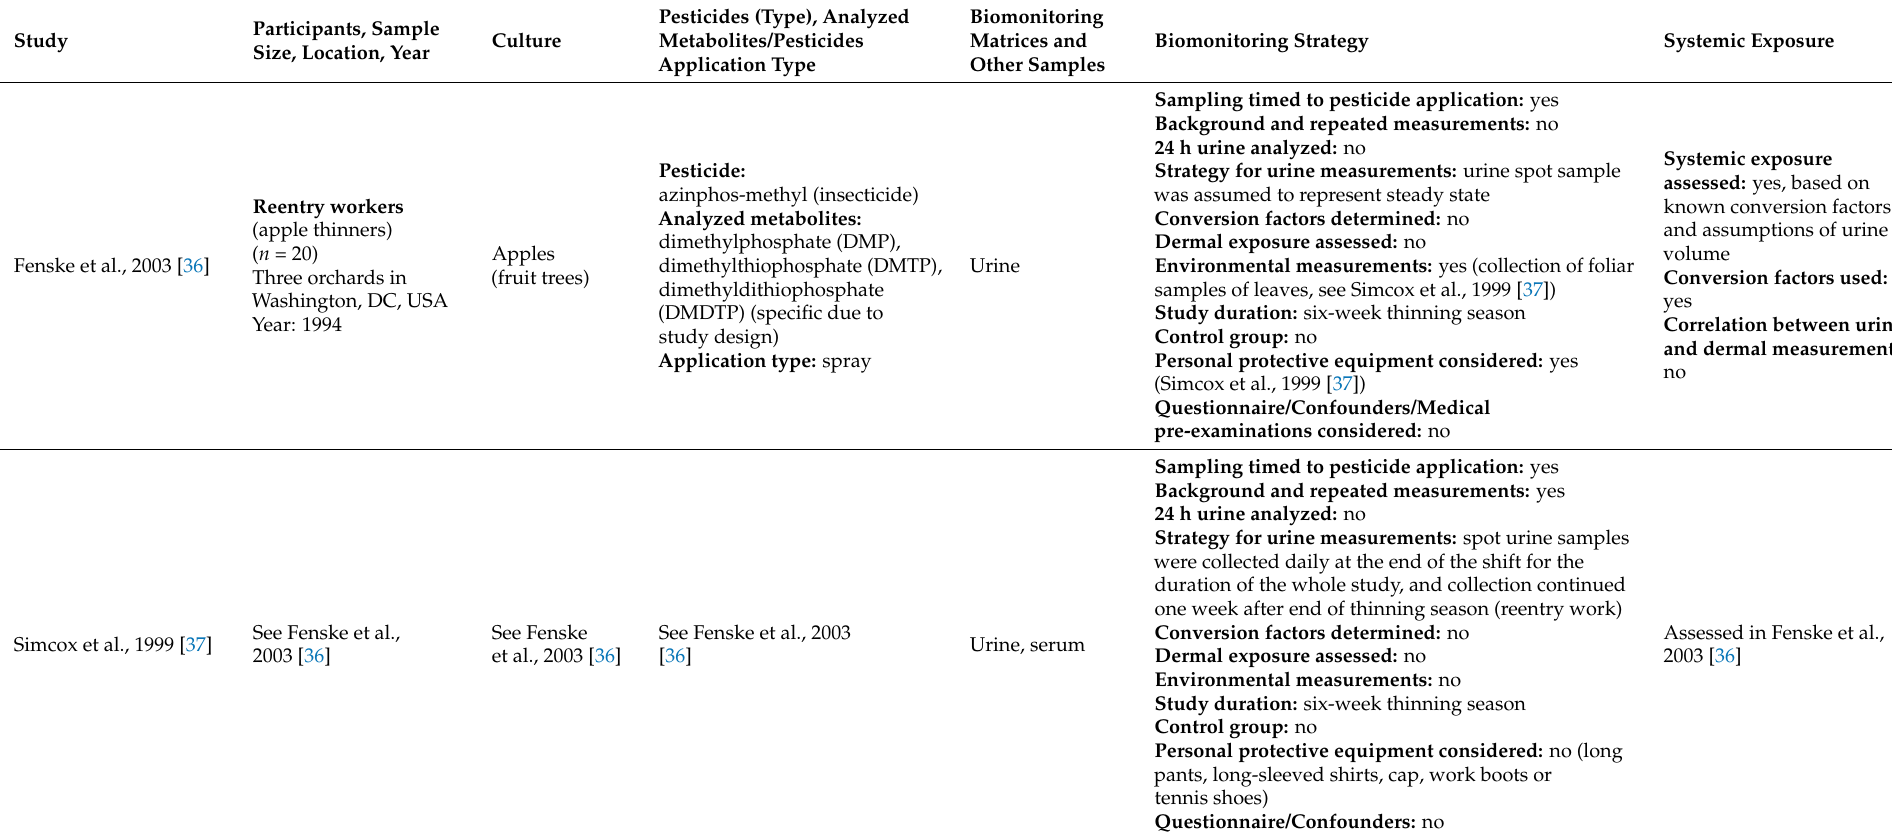
Table 1. Study characteristics of studies on fruit trees as target